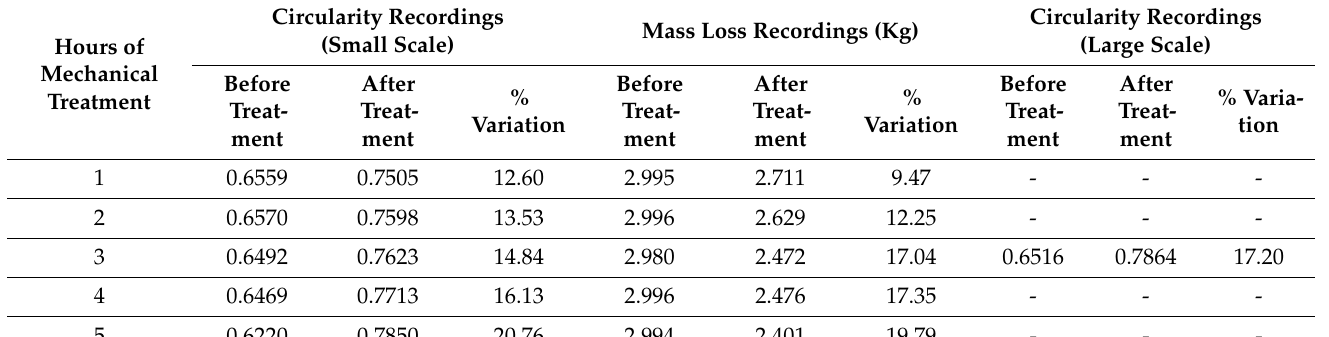
Figure 2. Changes is mass loss and circularity for 10 mm RCA subjected to small scale treatment for up to 5 h.